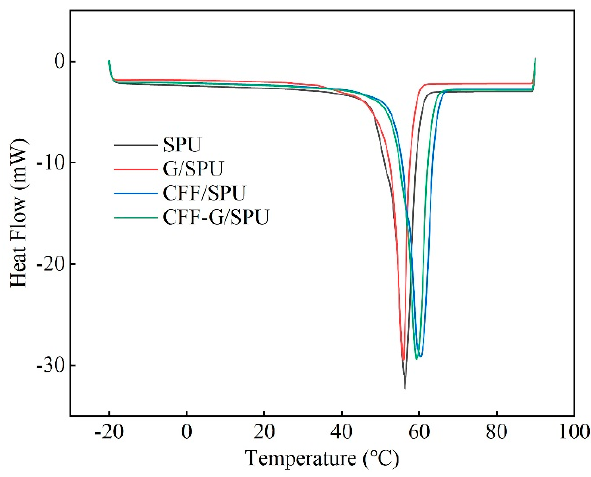
Figure 3. DSC curves of SPU, G/SPU, CFF/SPU and CFF-G/SPU.